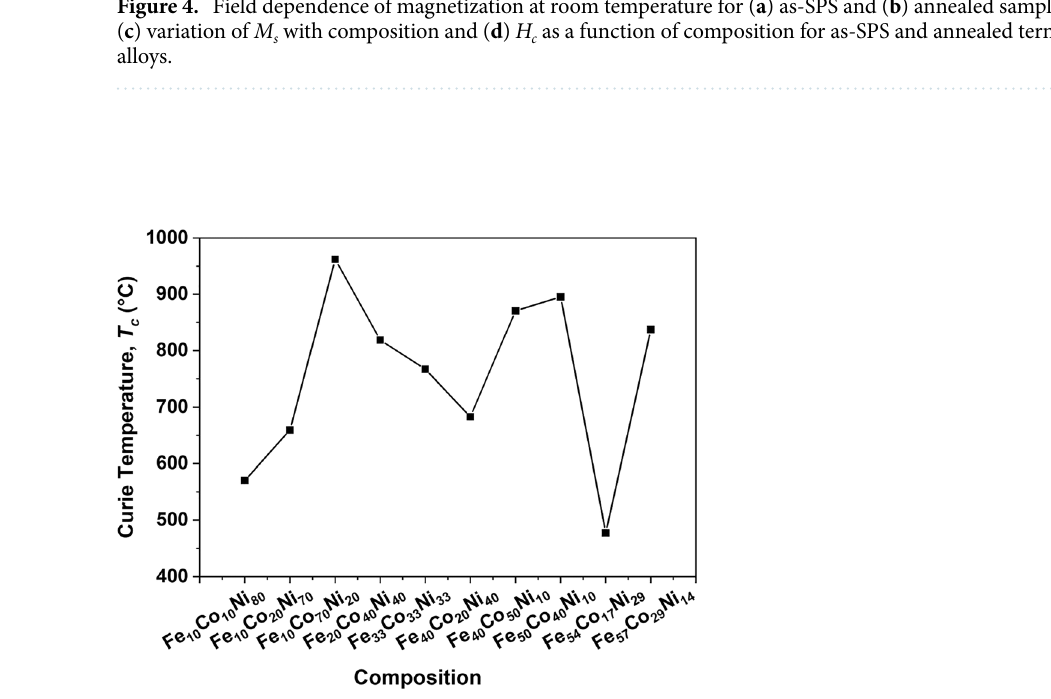
Figure 5. Curie temperature, T c , as a function of composition for annealed Fe–Co–Ni